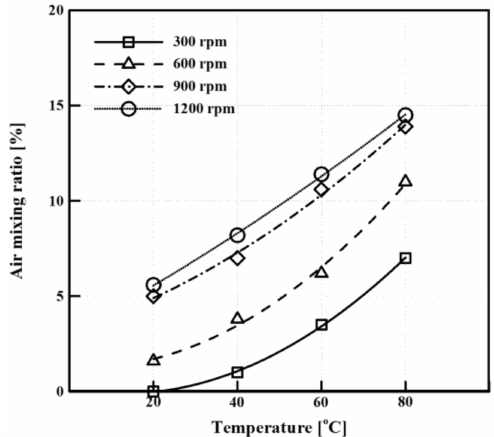
Figure 7. Air mixing ratio according to temperature at 0.084